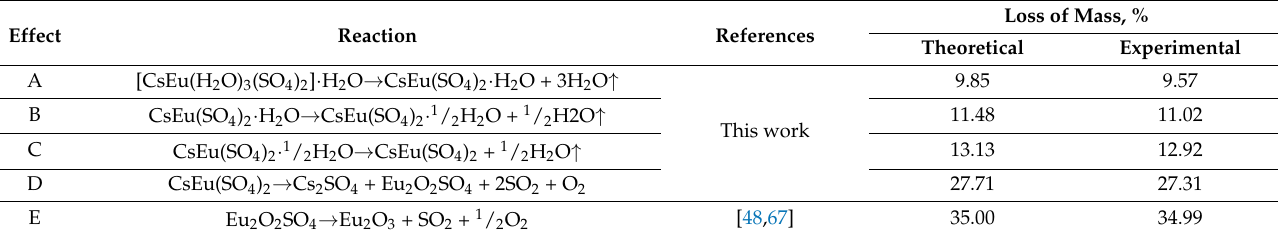
Figure 11. DSC/TG curves recorded for [CsEu(H 2 O) 3 (SO 4 ) 2 ]·H 2 O. Table 3. Thermal effects in [CsEu(H 2 O) 3 (SO 4 ) 2 ]·H 2 O.